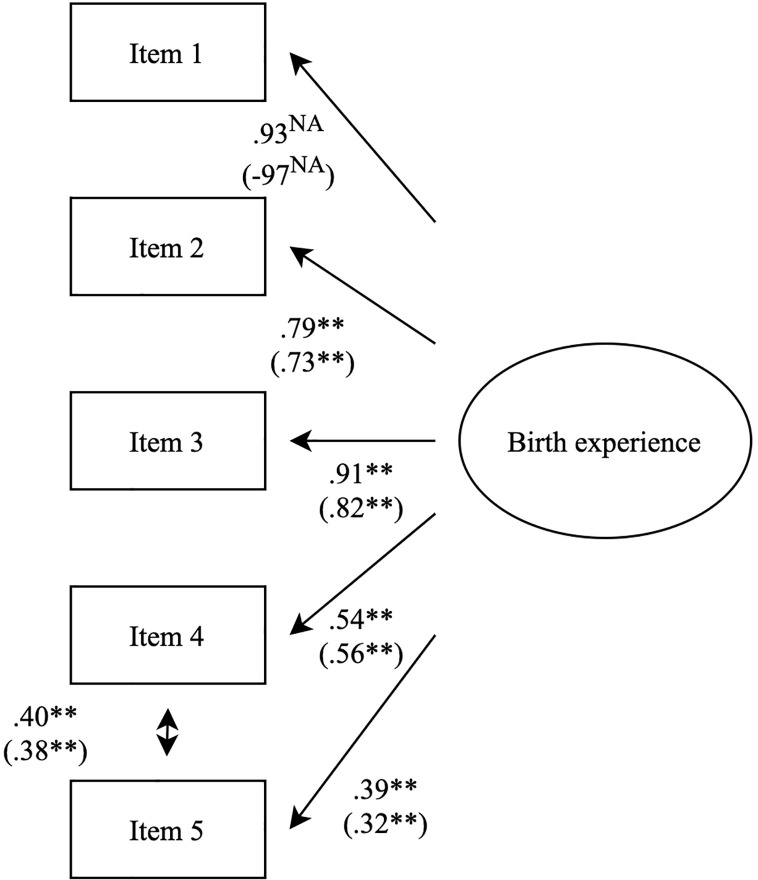
Factor structure for the latent variable on birth experience. Results of the large sample are reported first, and in brackets are results of the smaller sample. These results are of the completely standardized solution, which is why the first birth experience item is not fixed to 1. Significances are marked in the following manner: **p < .05.